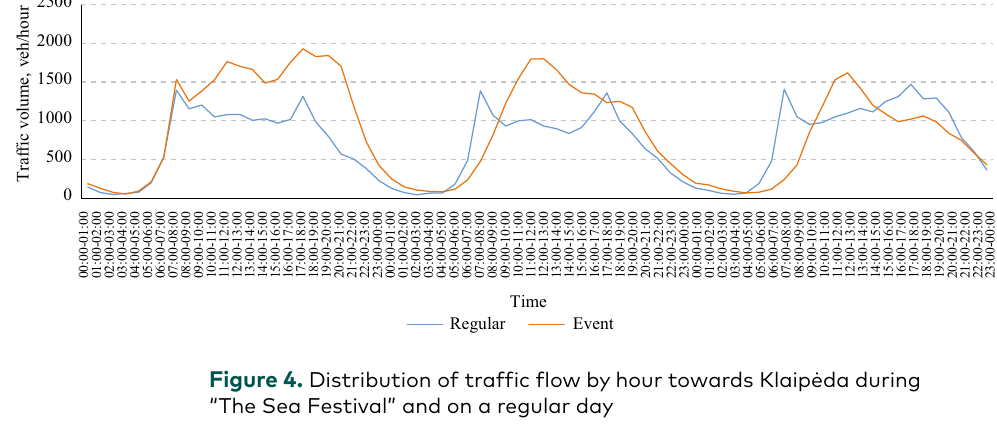
Figure 4. Distribution of traffic flow by hour towards Klaipėda during “The Sea Festival” and on a regular